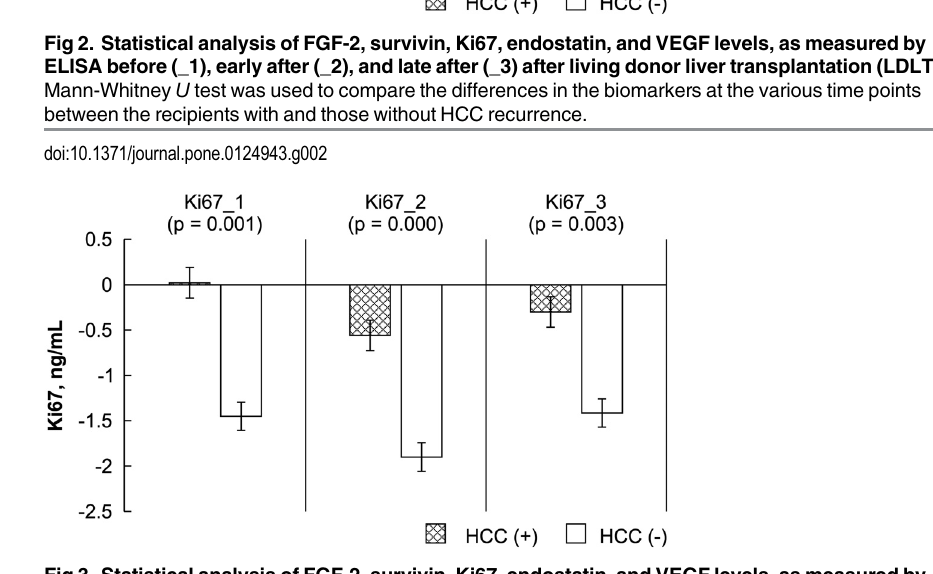
Fig 3. Statistical analysis of FGF-2, survivin, Ki67, endostatin, and VEGF levels, as measured by ELISA before (_1), early after (_2), and late after (_3) after living donor liver transplantation (LDLT). The Mann-Whitney U test was used to compare the differences in the biomarkers at the various time points between the recipients with and those without HCC recurrence.